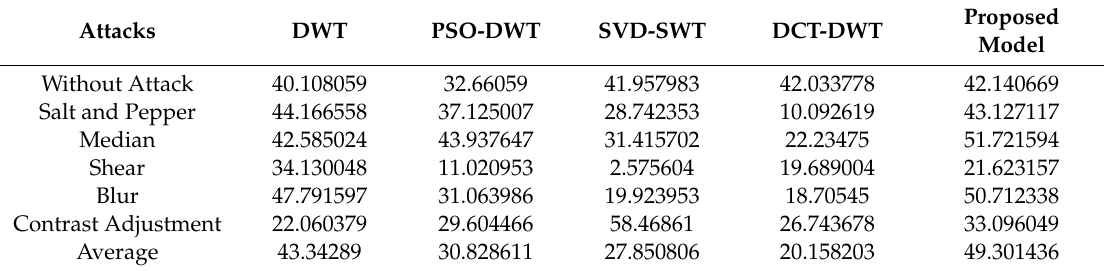
Table 1. Peak signal-to-noise ratio (PSNR) values of di ff erent models and the proposed model after extraction of the watermark.